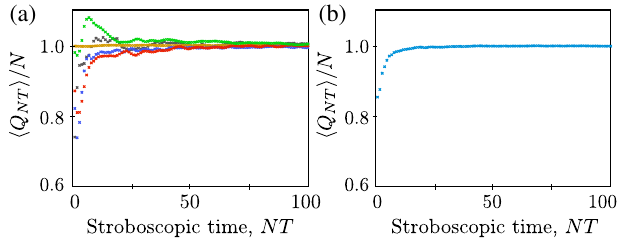
FIG. 9. Quantized charge pumping in the AFAI in a single disorder realization for a system of size 50 × 50 . All parameters are the same as in Fig. 6. (a) Cumulative average of pumped charge per cycle, h Q i NT =N , resolved for five different vertical cuts across the cylinder (cuts along the y direction, cf. Fig. 3). The spread of asymptotic values arises from numerical error in the finite time differences used for evaluating the integral in Eq. (13). (b) The pumped charge, averaged over all longitudinal cuts in the same finite-sized system. For a thermodynamically large system, averaging over all cuts is equivalent to averaging over disorder realizations; see Fig.